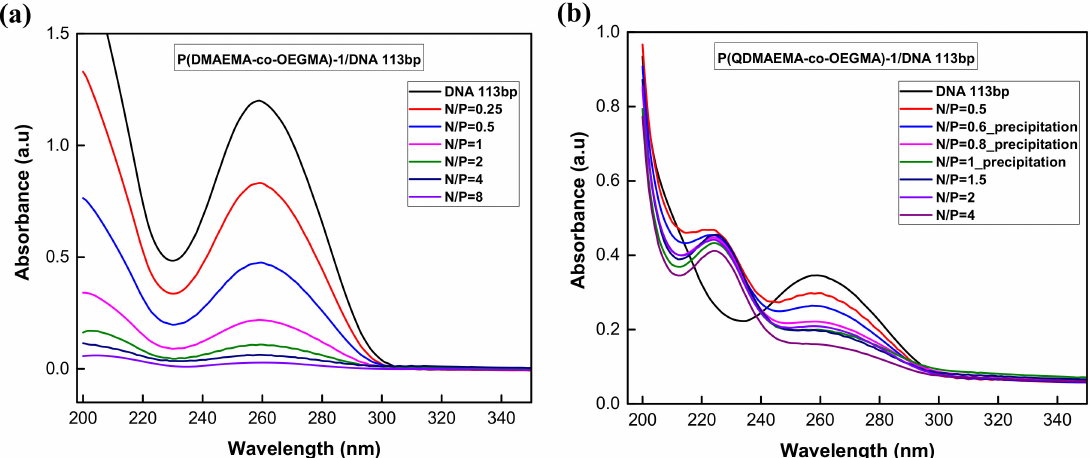
Figure 6. Representative UV–vis absorption spectra of ( a ) P(DMAEMA-co-OEGMA)-1/DNA 113 bp polyplexes and ( b ) P(QDMAEMA-co-OEGMA)-1/DNA 113 bp polyplexes in N/P ratios generally ranging from 0.25 to